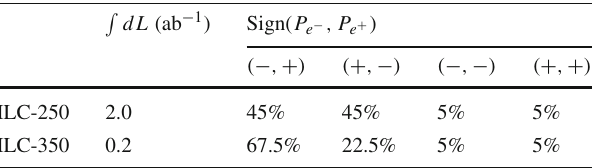
Fig. 4 The total cross-section normalized by the SM prediction of the √ s . process e − e + → τ − τ + as a function of the center-of-mass energy The LEP-II data are shown in blue error bars [14]. The SM calculation performed using GRACE at the next-to-leading order is represented by the black solid line where a NP τ = 0. The dashed and dotted lines correspond to the values a NP τ = 2 . 75 and 2.46, respectively Table 1 Luminosity sharing between different polarization configura- √ s = 250, and 350 GeV. The values tions for two stages of the ILC at are taken from Table 5 of Refs. [61,62]